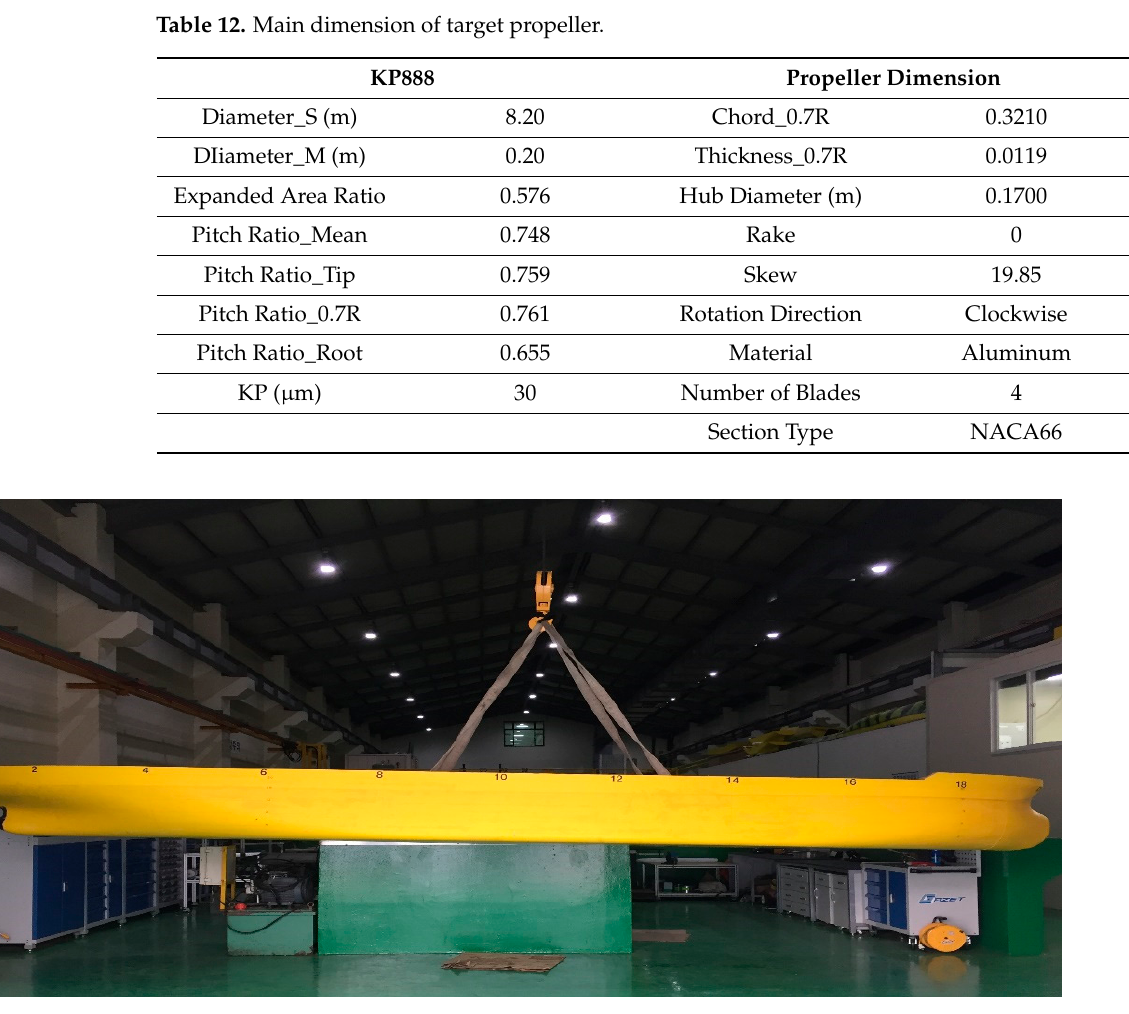
Figure 14. The model ship of 158K crude oil tanker.